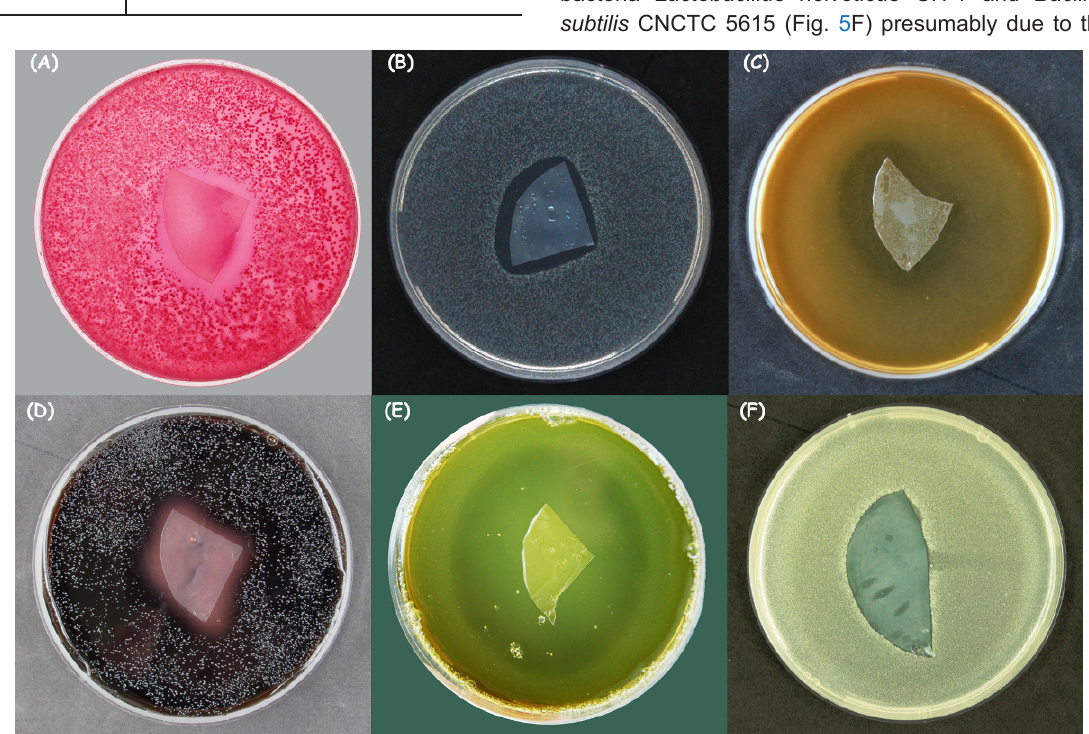
Figure 5. The growth inhibition of indicator bacteria: Escherichia coli (A) and Pseudomonas fluorescens (B) by ionomer film with GOX; Lactobacillus helveticus (C) and Listeria innocua (D) by polyamide film with GOX; Listeria ivanovii (E) by polyamide film with GOX during cold storage at 4°C; Bacillus subtilis (F) by cellulose film releasing